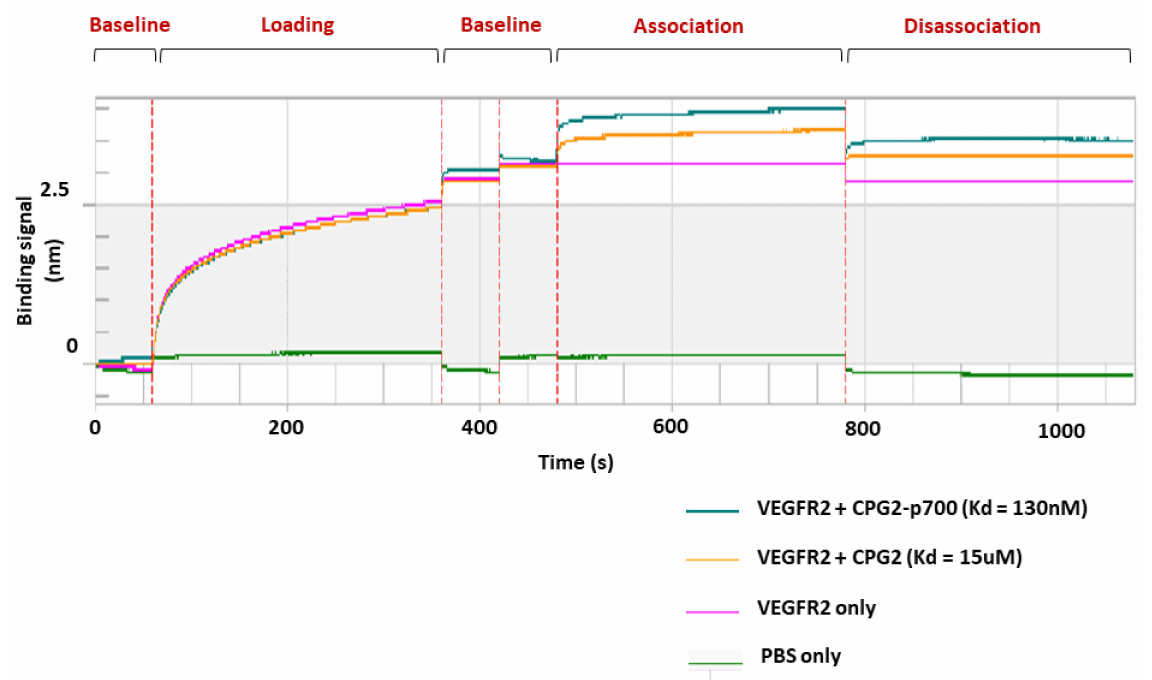
Figure 5. A representative biolayer interferometry experiment comparing the interaction between recombinant CPG2 or CPG2-p700 and VEGFR2. The binding signal is the wavelength shift detected by the BLItz machine and corresponds to the change in thickness of the biolayer as a result of the interaction between the recombinant proteins (CPG2 or CPG2-p700) and a VEGFR2-coated biosensor and is plotted against the duration of the interactions. Four runs are shown with PBS only loaded (green line), VEGFR2 only loaded (purple line) and VEGFR2 loaded followed by CPG2 (yellow line) or CPG2-p700 (green line). The first loading curve is the binding of VEGFR2-Fc to the protein A coated sensor. The sensor was then washed by dipping into PBS (baseline) before dipping into the CPG2 protein solutions (association). The sensor was then transferred to PBS and dissociation measured. Binding affinity (dissociation constant, Kd) was calculated using the BLItz software based on five repeats using increasing concentrations (300 nM to 10 mM) of recombinant proteins. CPG2-p700 showed a 100-fold increase in binding affinity compared with